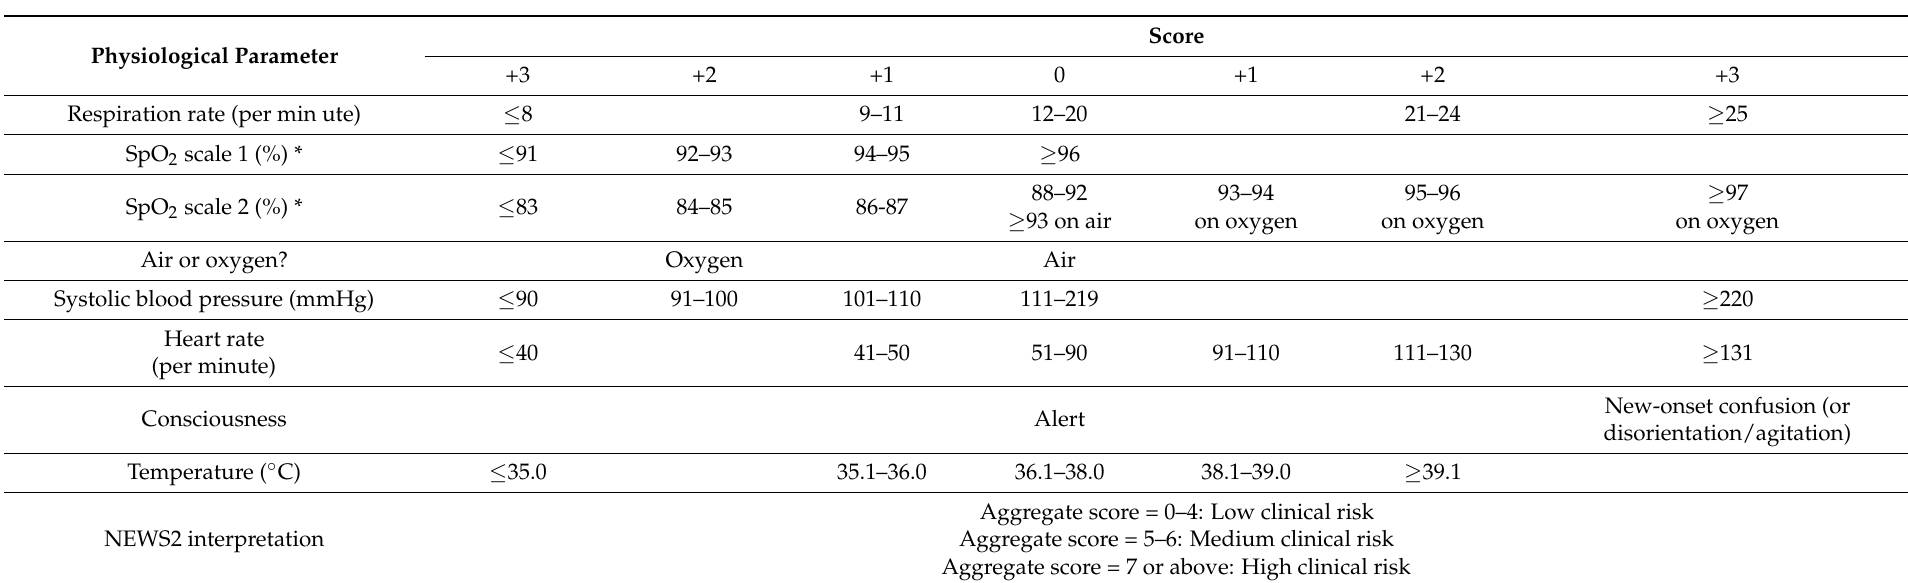
Table 5. NEWS (National Early Warning Score) 2 scoring system calculation and